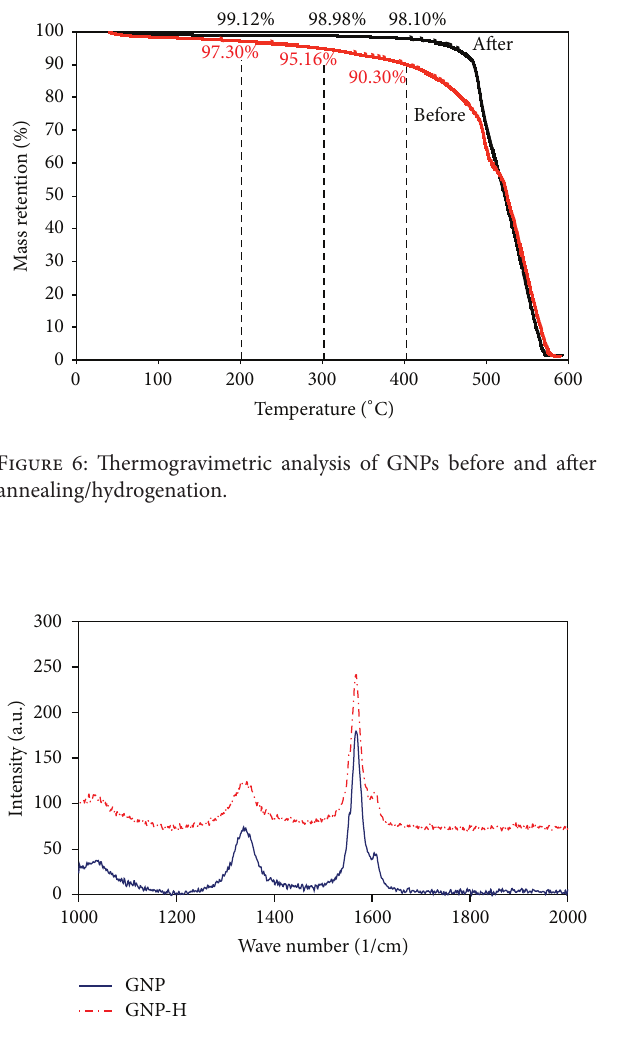
Figure 7: Raman spectroscopy spectra of unreduced (GNP) and reduced GNPs